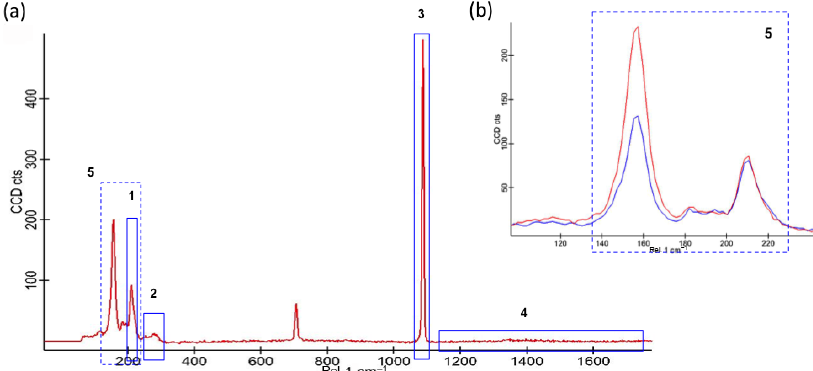
Figure 5. The typical Raman spectra from S. biradiata and F. tenuicostata (a) . The blue boxes correspond to the filters applied to the data: fil- ter 1 ( (cid:54) peak area) centred at 209cm − 1 (width = 36.6cm − 1 ) , filter 2 ( (cid:54) peak area) centred at 282cm − 1 (width = 66.3cm − 1 ) , filter 3 (centre of mass, weighted width) centred at 1085cm − 1 (width = 36.6cm − 1 ) and filter 4 ( (cid:54) peak area) centred at 1450cm − 1 (width = 600cm − 1 ) . The blue dashed box, filter 5, encapsulates filter 1 and a filter centred at 152cm − 1 ( (cid:54) peak area, width = 36.6cm − 1 ) to represent their cal- culated peak intensity ratio. The blue and red spectra (b) show the peak intensity difference seen at 152 and 209cm − 1 . Each filter measures the peak area, except filter 3, which measures the full width at half maximum and produces a qualitative map. Filter 1 targeted the arago- nitic phase, and filter 2 targeted calcite. Filter 3, by measuring variation in FWHM, represents crystallinity and crystallite order. Filter 4, by targeting the tail of the spectrum, shows fluorescence, since the peaks related to organics tend to show best in the tail of the spectrum. And finally, the peak intensity ratios (filter 5) show changes in the crystallite orientation (aragonite crystallites).